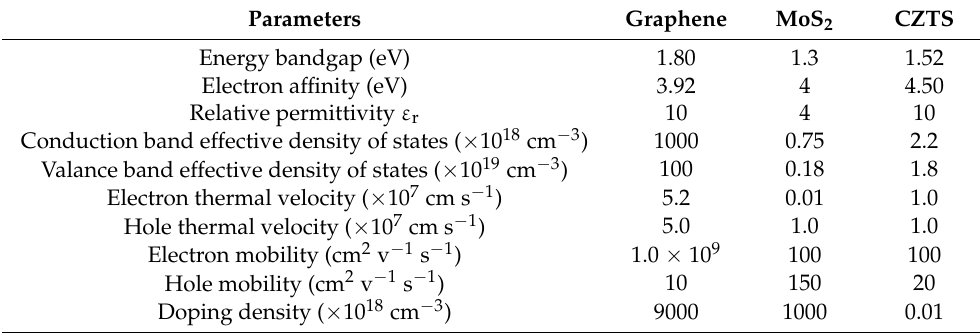
Table 1. Input optical and electrical parameters of CZTS solar